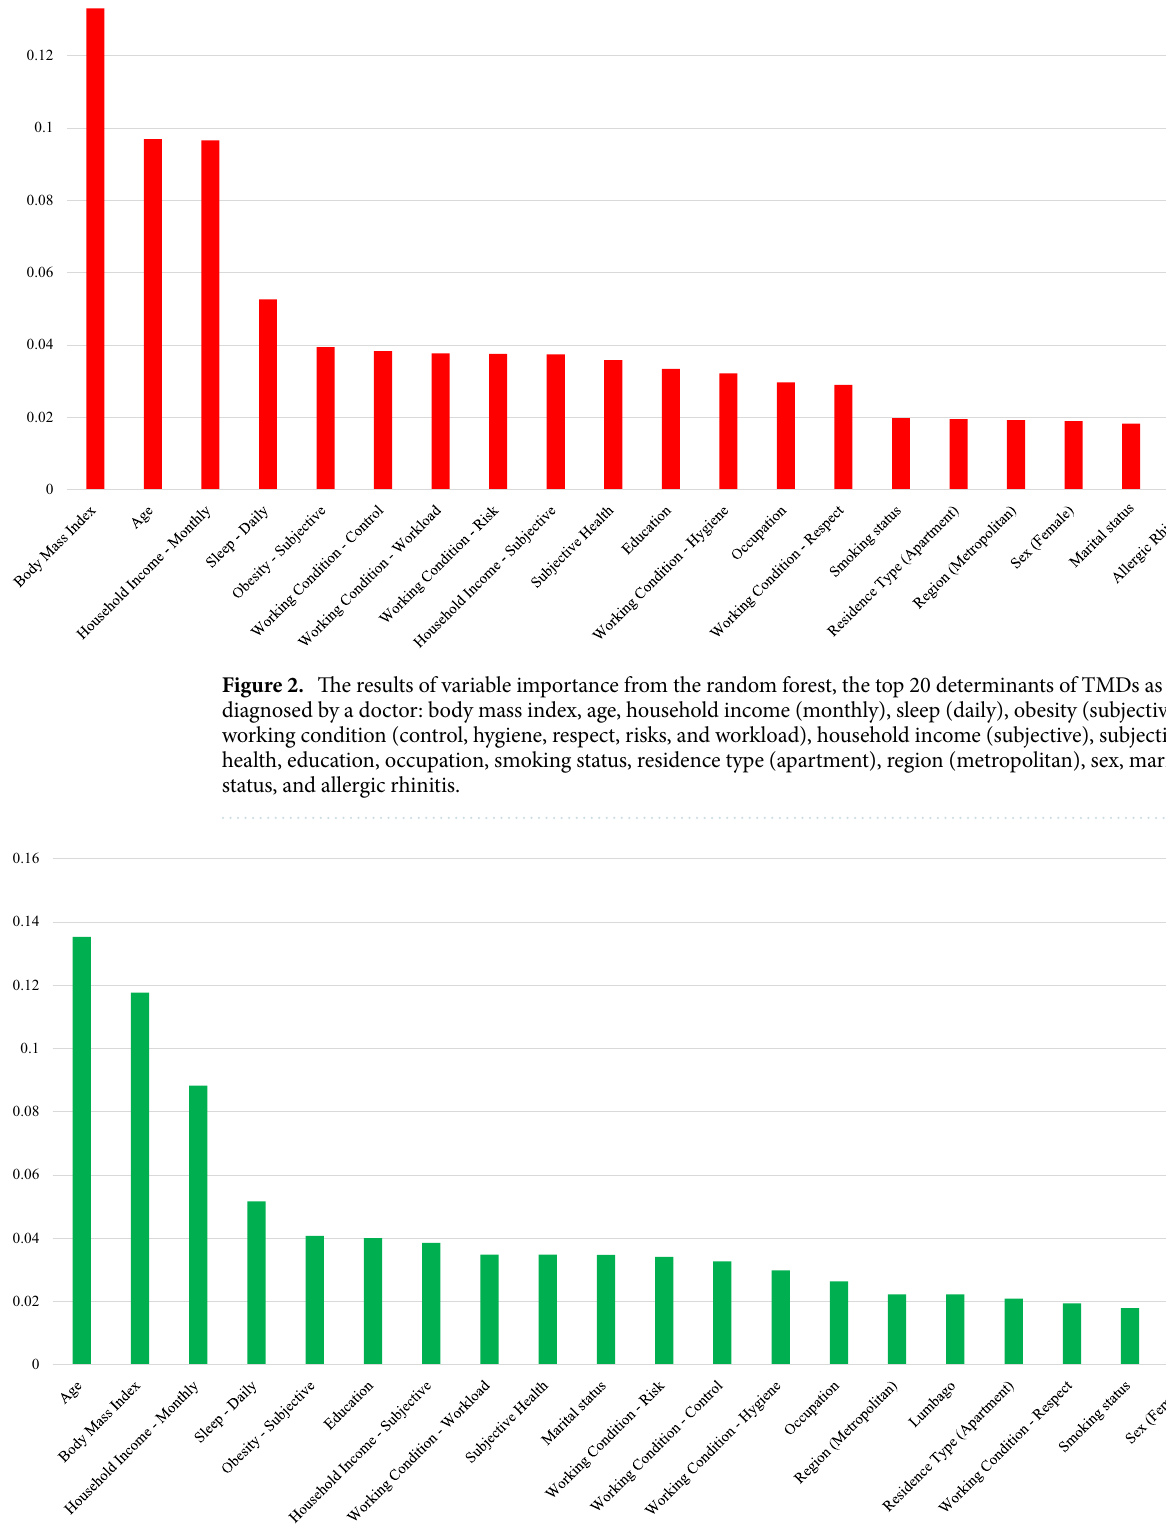
Figure 3. Based on variable importance from the random forest with under-sampling (101:404), the top 20 determinants of self-reported TMDs are age, body mass index, household income (monthly), sleep (daily), obesity (subjective), education, household income (subjective), working conditions (control, hygiene, respect, risks, and workload), subjective health, marital status, occupation, region (metropolitan), lumbago, residence type (apartment), smoking status, and